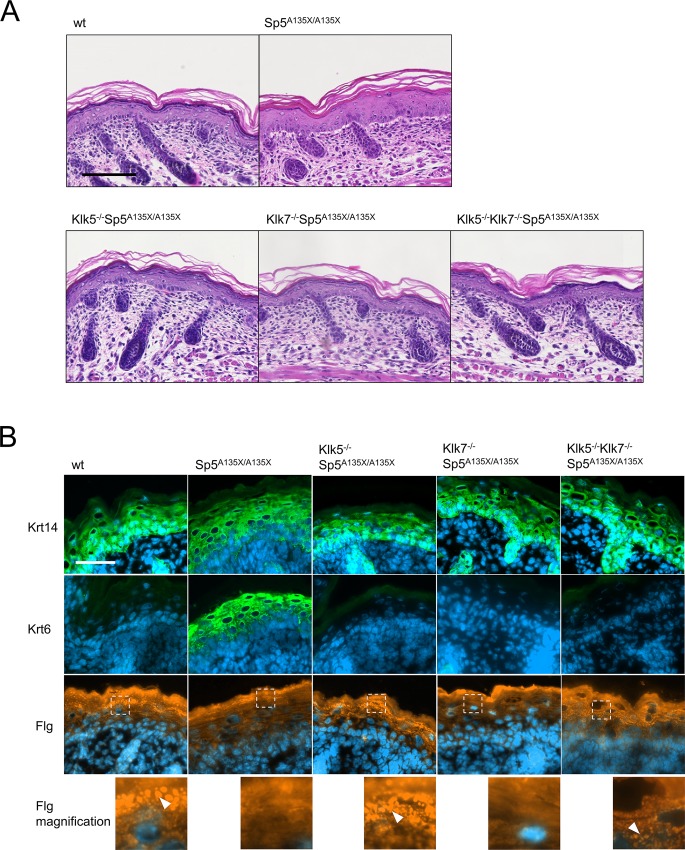
Histological analysis of epidermis structure at E18.5 dpc and P0.(A) Hematoxylin and eosin stained skin sections from newborn mice showed a reduced granular layer and acanthosis in epidermis of Sp5A135X/A135X pups; no obvious defects were observed in the other groups, Scale bar, 100 μm. (B) Analysis of epidermal differentiation in the skin from E18.5 dpc embryos. Sections were stained with antibodies against keratin14 (Krt14), keratin6 (Krt6) and fillagrin (Flg). Increased expression of Krt14 was observed in Sp5A135X/A135X embryos, which also strongly express the stress marker Krt6. Expression of both Krt6 and Krt14 was not altered in Klk5-/-Sp5A135X/A135X, Klk7-/-Sp5A135X/A135X and Klk5-/-Klk7-/-Sp5A135X/A135X. Flg staining revealed absence of profilaggrin granules in Sp5A135X/A135X and Klk7-/-Sp5A135X/A135X embryos whereas these granules were present in wt, Klk5-/-Sp5A135X/A135X and Klk5-/-Klk7-/-Sp5A135X/A135X mice (white arrowheads). Scale bar, 50 μm.